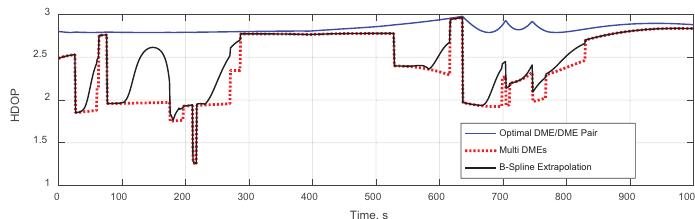
Figure 10. Mean-squared error of positioning in horizontal plane